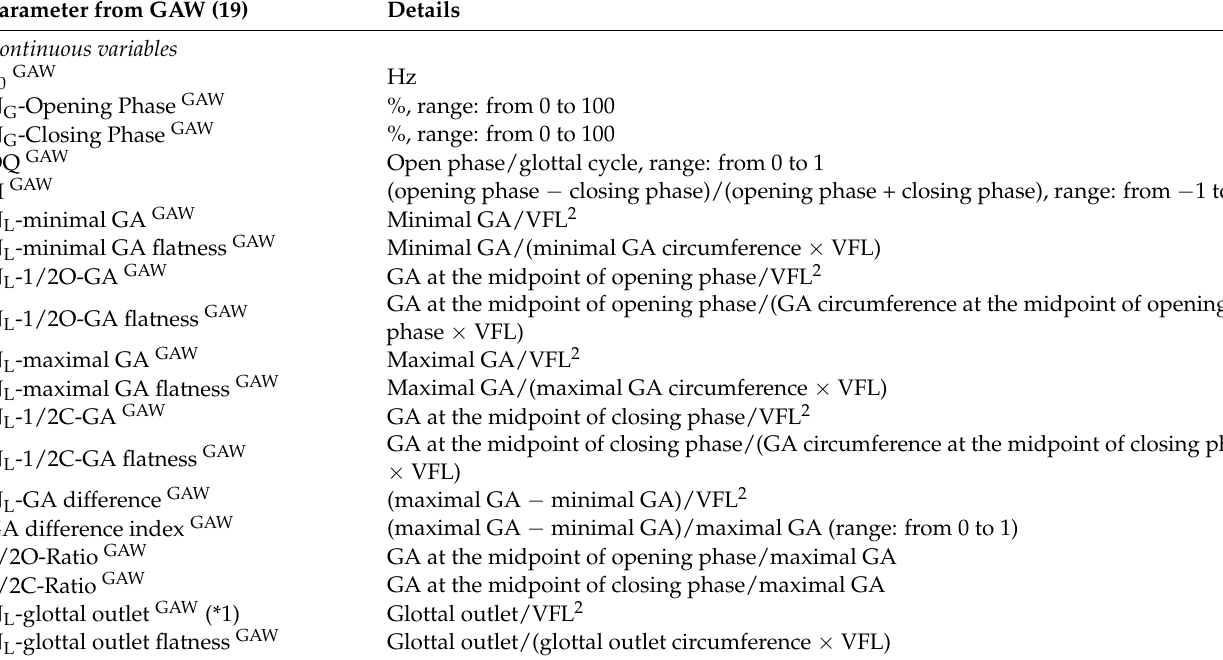
Table 6. Parameters from glottal area waveform